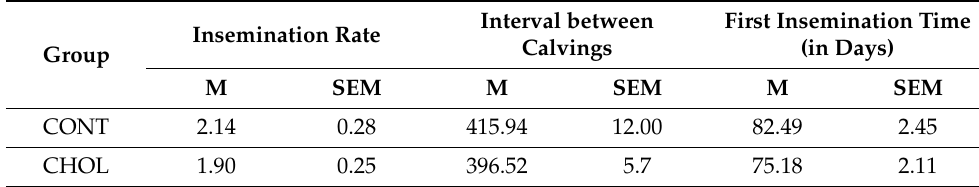
Table 1. Reproduction traits of cows in the CHOL and CONT groups. Interval between First Insemination Time Calvings (in Days) Group Insemination Rate M SEM M SEM M SEM CONT 2.14 0.28 415.94 12.00 82.49 CHOL 1.90